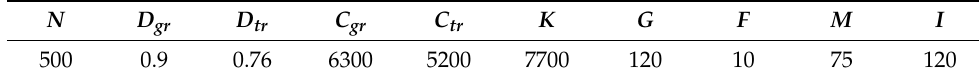
Table 3. The initial values of all